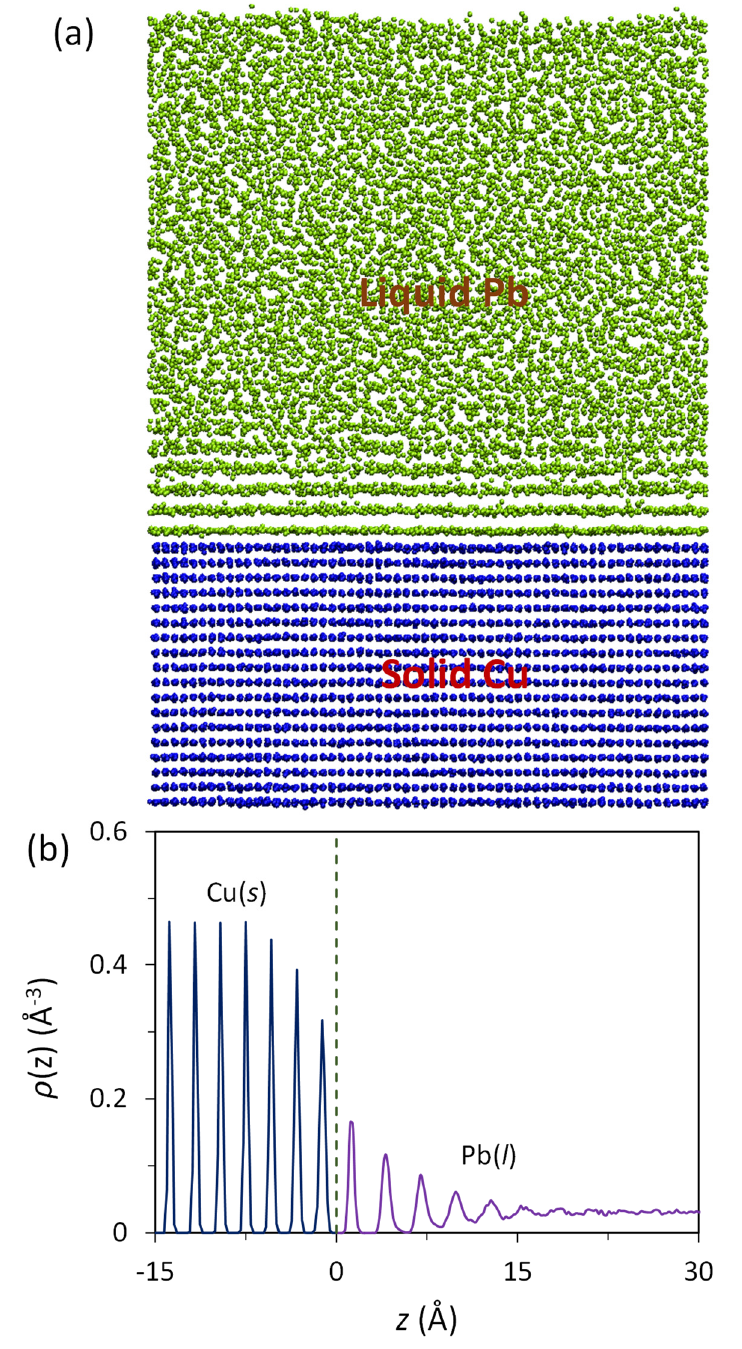
Figure 1. Prenucleation phenomenon in the Pb( l )/Cu( s ) system equilibrated at 625 K. ( a ) Snapshot (front view) of the system and ( b ) atomic density profile, ρ (z), as a function of distance, z , from the interface. The dashed line at z = 0 in ( b ) marks the Pb( l )/Cu( s ) interface. Liquid Pb adjacent to the liquid/substrate interface shows 6 distinctive atomic layers.